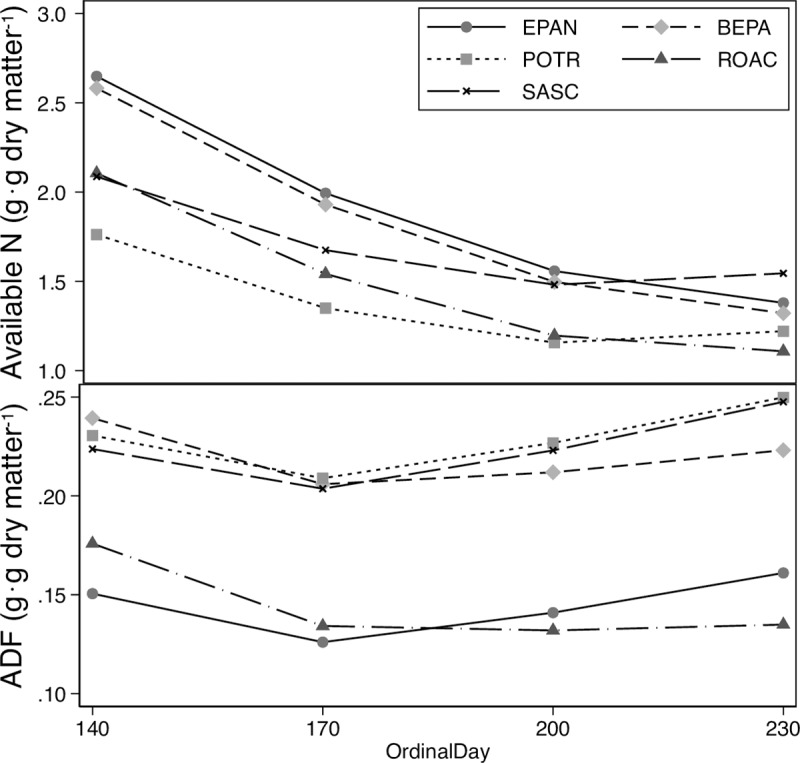
Forage quality.Phenology of available N (g·100 g-1; top panel) and fiber content (ADF g·g-1 dry matter; bottom panel) of forages available to moose through the summer (May–August; ordinal day 140–240) at the Kenai Moose Research Center, Kenai Peninsula, Alaska, USA, in 2014–2016. Symbols are estimated margins for each species. Lines are predicted relationships from mixed model regressions of concentration against time. Key: Betula papyrifera (BEPA)–dashed line and gray diamond; Populus tremuloides (POTR)–dotted line and gray square; Rosa aciculari (ROAC)–dashed line with dots and black triangle; Salix scouleriana (SASC)–short dashed line and black x’s; Epilobium angustifolium (EPAN)–solid line and black circle. The period of early lactation is from ordinal day 140 to 170.